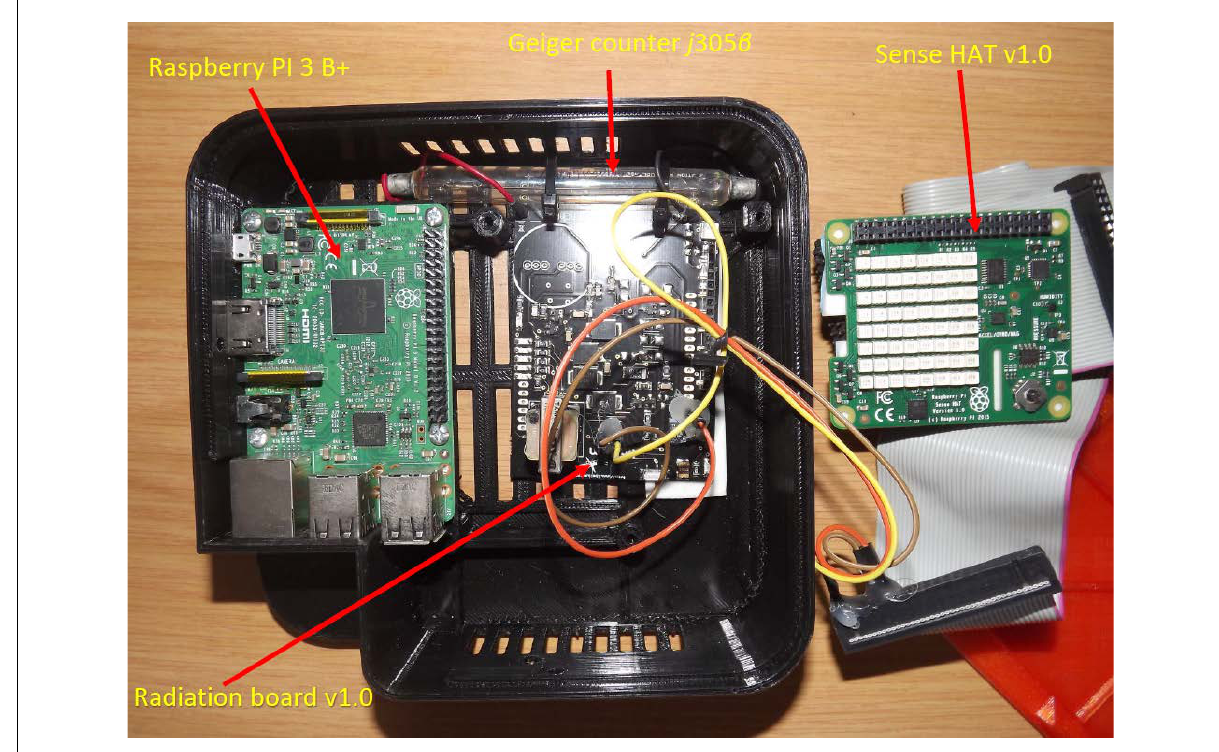
The HARM housing opened to reveal the detector electronics, showing the Raspberry Pi 3 Model B+, the GM tube and its control board, and the Sense HAT